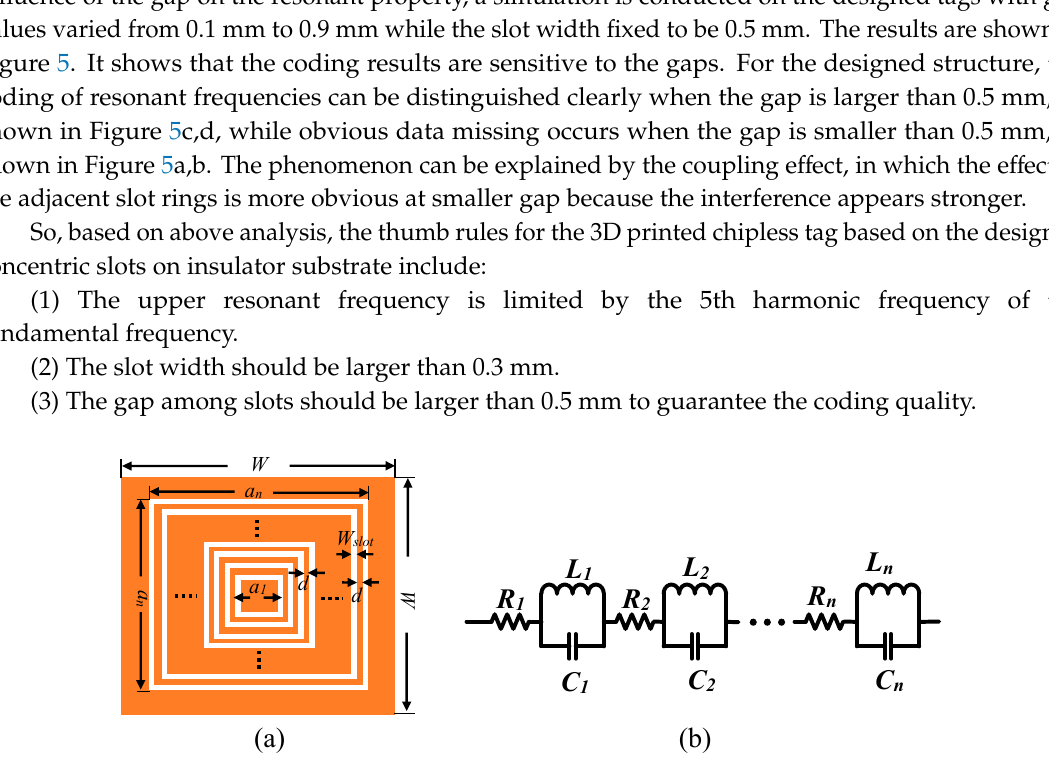
Figure 4. ( a ) Diagram of the designed concentric rectangular slots printed on substrate; ( b ) Equivalent circuits of rectangular slot ring resonators. Each rectangular slot ring is depicted as a LC shunt circuit.